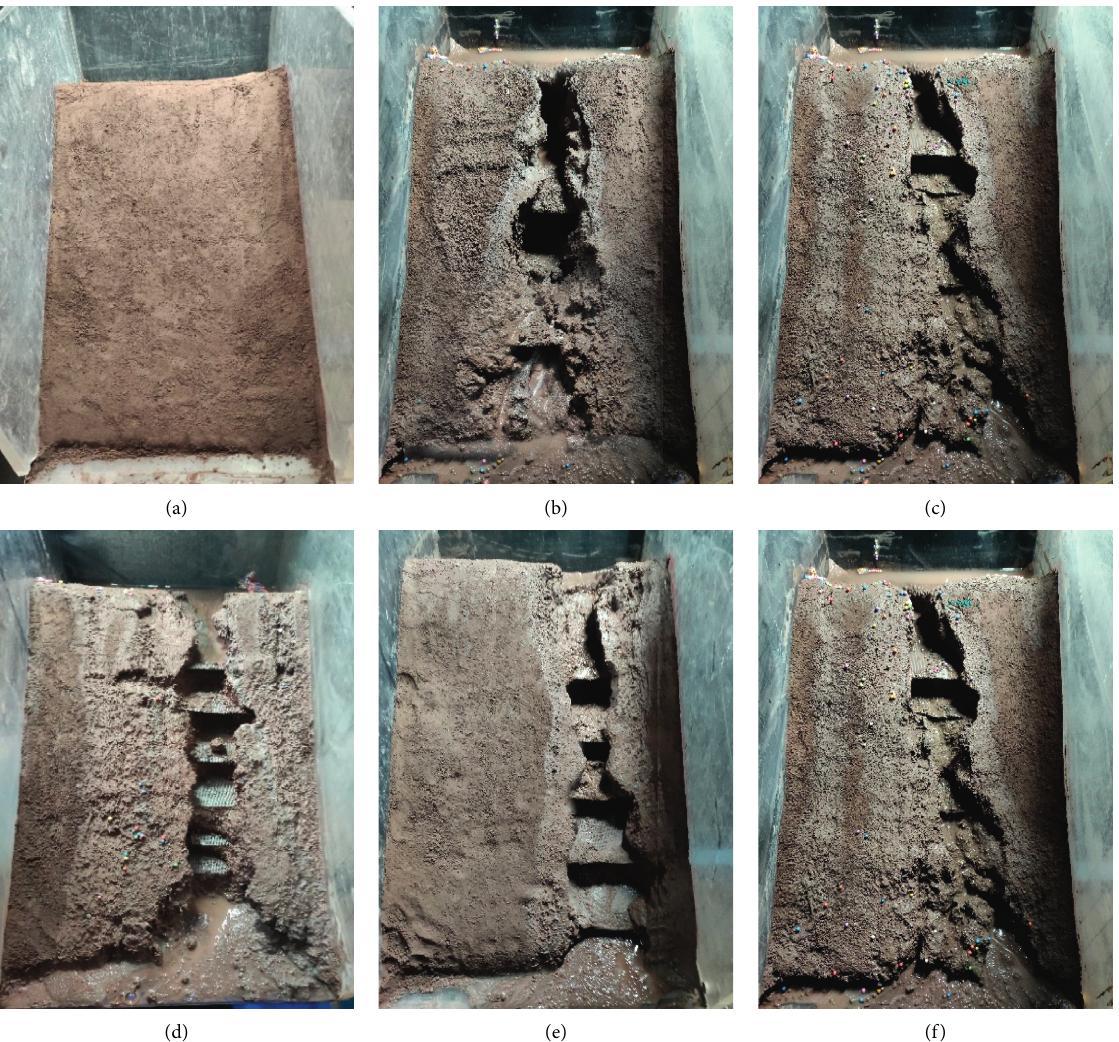
Figure 10: Diagrams of reinforced tailings dam failure. (a) Front of reinforced tailings. (b) d � 7.5 cm. (c) d � 6.0 cm. (d) d � 4.5 cm. (e) d � 4.0 cm. (f) d � 3.0